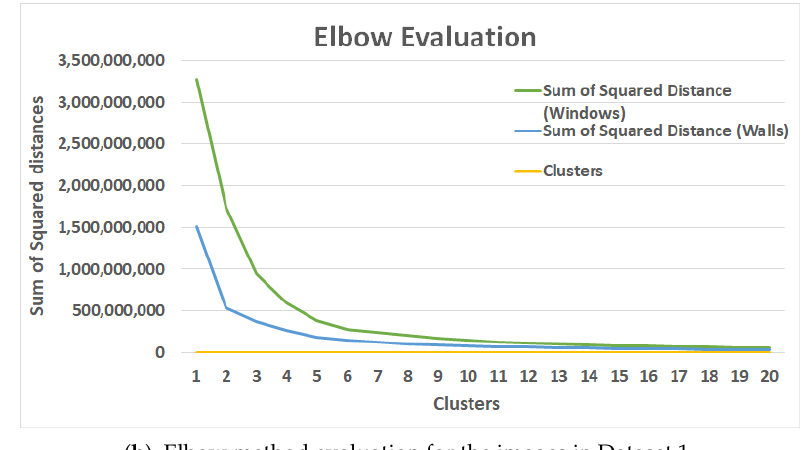
Figure 8. The K-means-optimal cluster evaluation and temperature